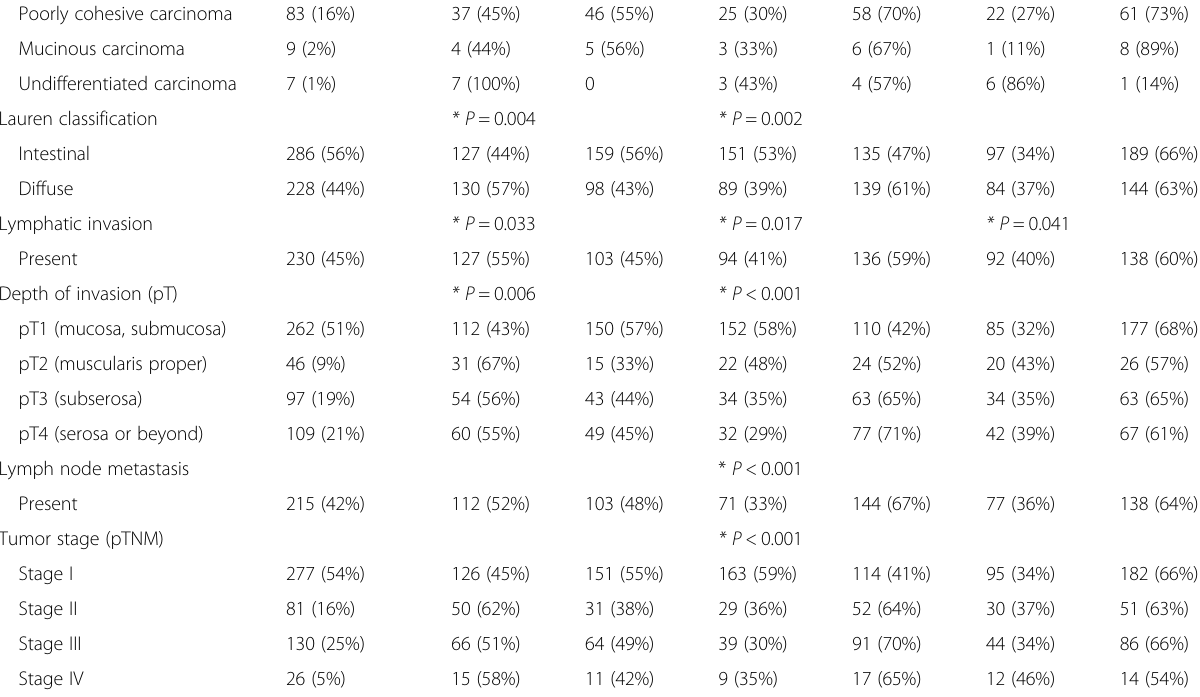
Table 1 Relationship Between Clinicopathological Features and PD-L1 Expression and Tumor-Infiltrating Lymphocytes in the Entire Cohort